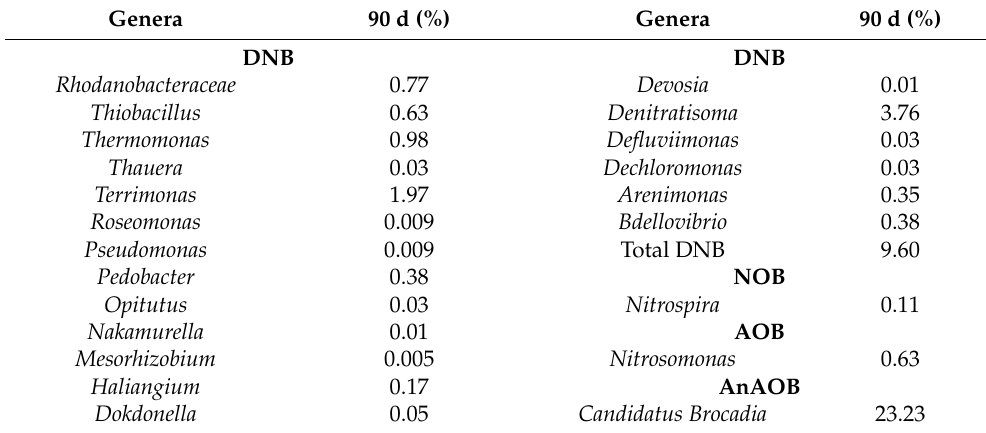
Table 2. Nitrogen-metabolism-related bacteria and their abundances in the MBBR.